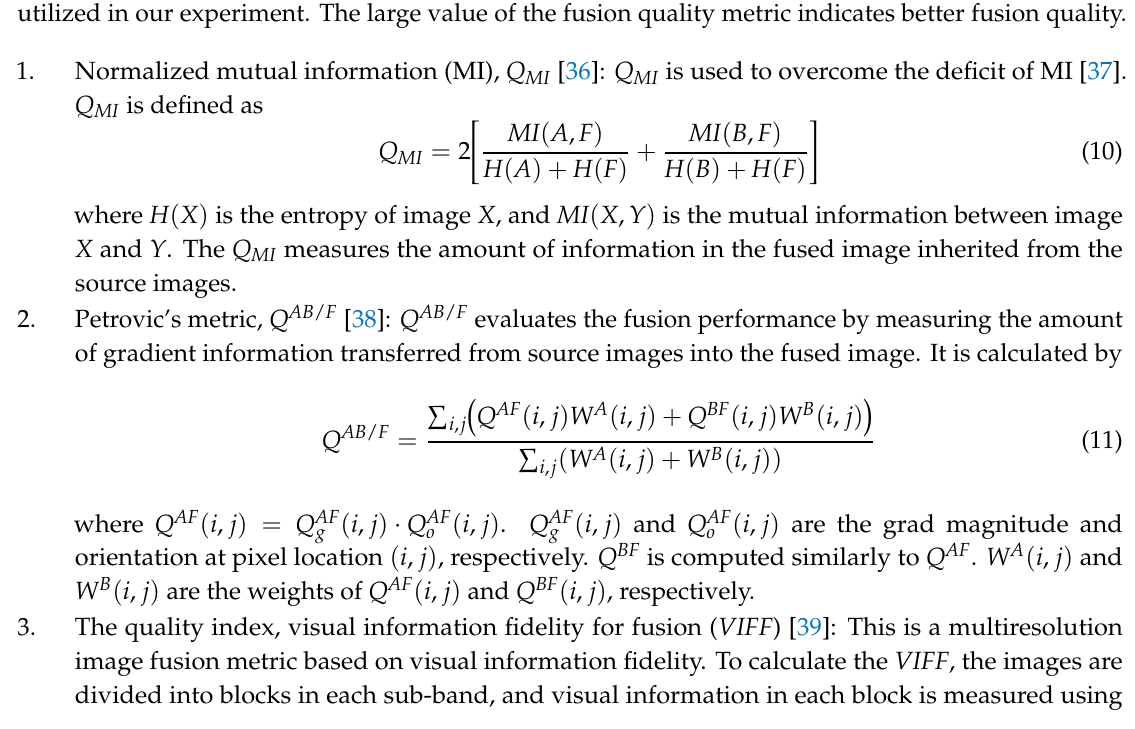
Figure 7. Twenty pairs from the Lytro image dataset.